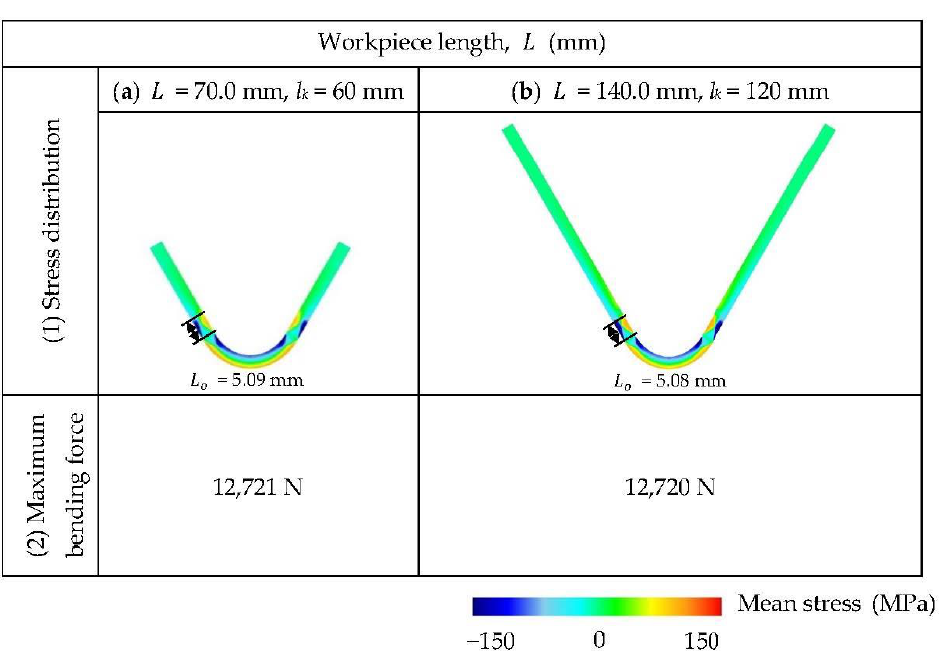
Figure 12. Illustration of mean stress and bending force with respect to workpiece length ( 𝑅 𝑝 = 9.0 mm, 𝑇 = 3 mm, 𝜃 = 60 ᵒ , AA1100-O).